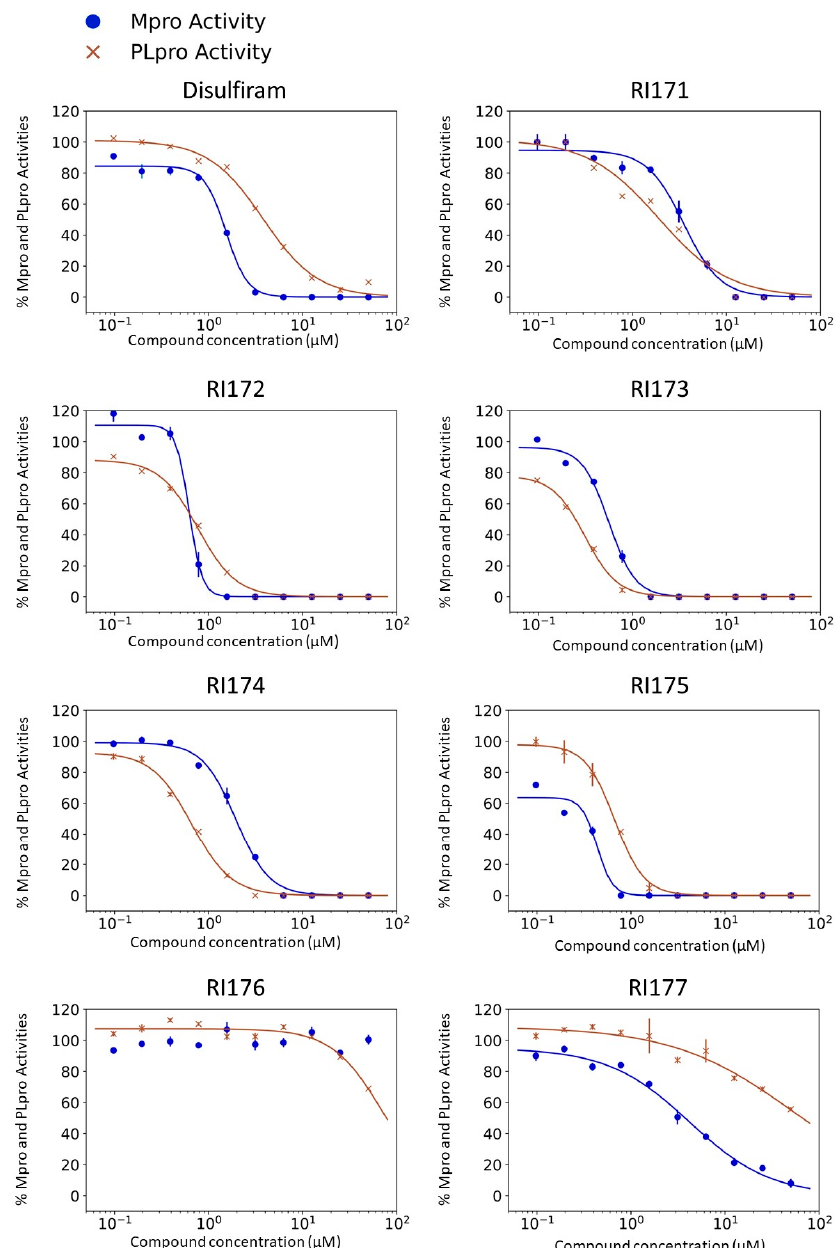
Figure 2. Selected thiuram disulfide or dithiobis-(thioformate) analogues show potent inhibition against SARS-CoV-2 Mpro and PLpro. Dose–response curves of disulfiram, RI171, RI172, RI173, RI174, RI175, and RI177 against SARS-CoV-2 Mpro (blue) and PLpro (brown). The disulfiram dose–response curve performed under the same conditions is shown for comparison. The proteolytic activities of both enzymes were determined by the enzymatic fluorescence assay and shown as percent activities relative to the negative control (DMSO). Error bars represent the standard errors of three independent